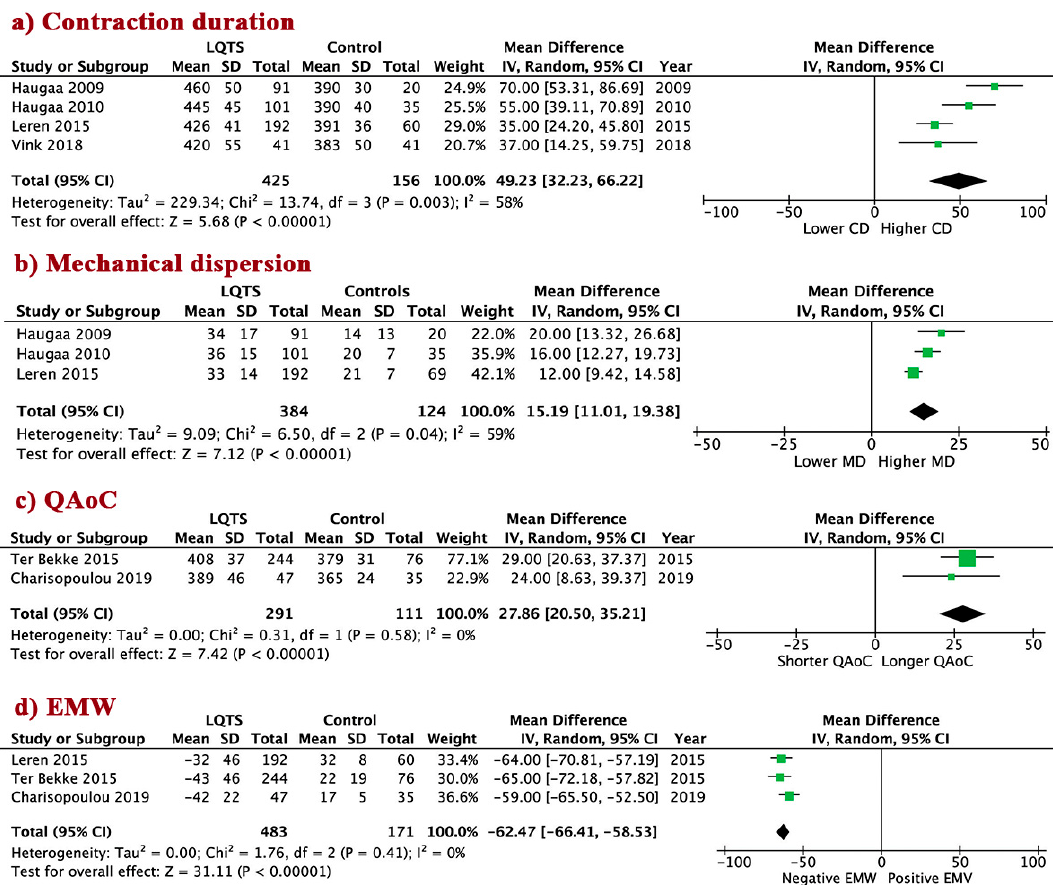
Figure 1. Mechanical abnormalities in long-QT syndrome (LQTS) patients vs. control. ( a ) Conctraction duration; ( b ) Mechanical dispersion; ( c ) QAoC; ( d ) EMW. LQTS: long QT syndrome; QAoC: QRS onset to peak systolic strain, EMW: electro-mechanical window; CD: contraction duration; MD: mechanical dispersion.